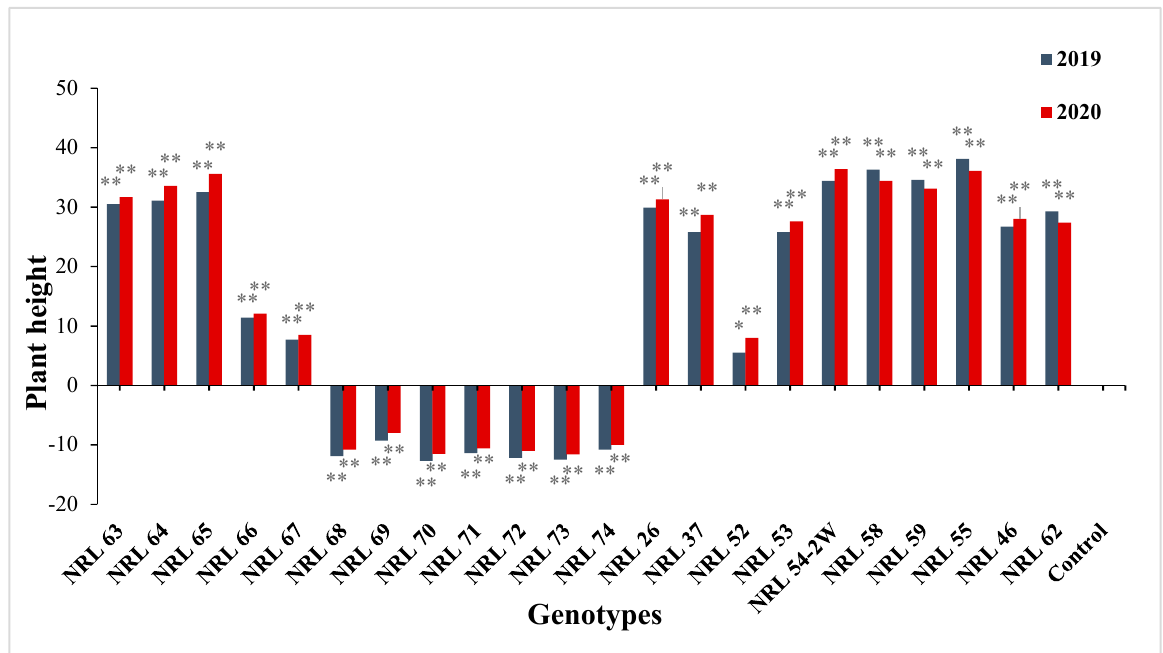
Figure 6. The percentage of advantage over commercial variety for plant height of studied genotypes during the 2019 and 2020 growing seasons. Means **: Highly significant at 1%; *: Significant at 5%; ns: Non-significant.